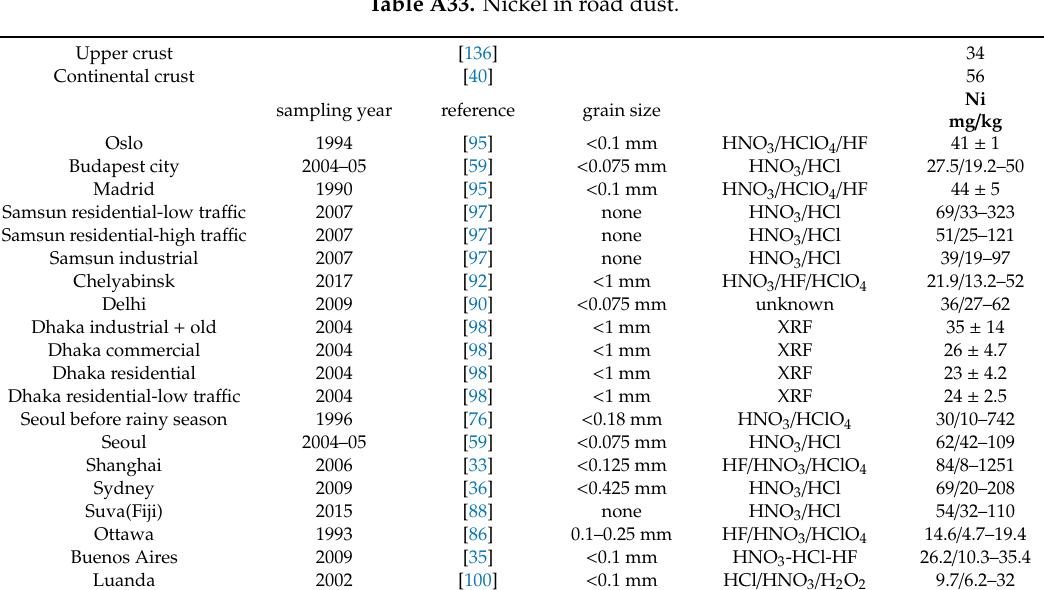
Table A33. Nickel in road dust.